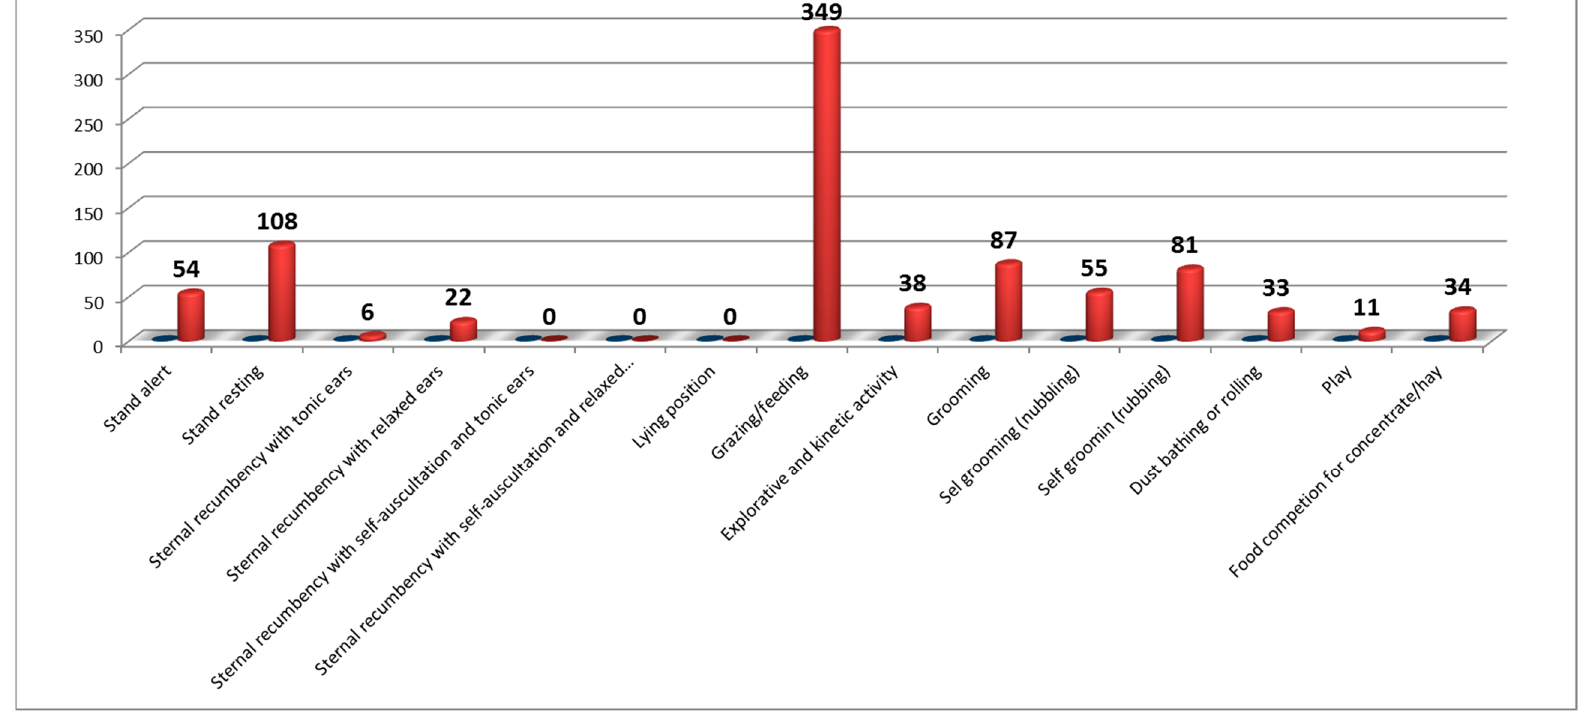
Figure 3. Diurnal ethogram (05:00 a.m.–08:00 p.m.) of the CG donkeys.